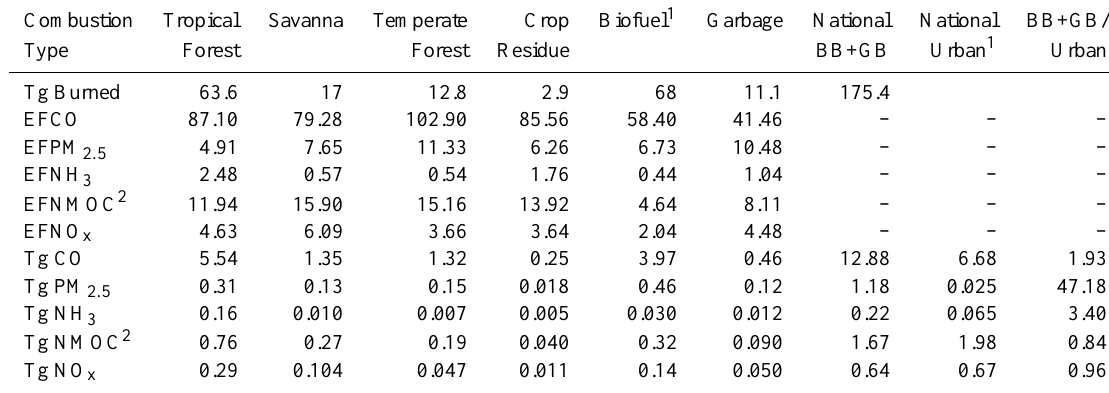
Table 8. Rough comparison of selected primary emissions from combustion in Mexico. Combustion Tropical Type Forest